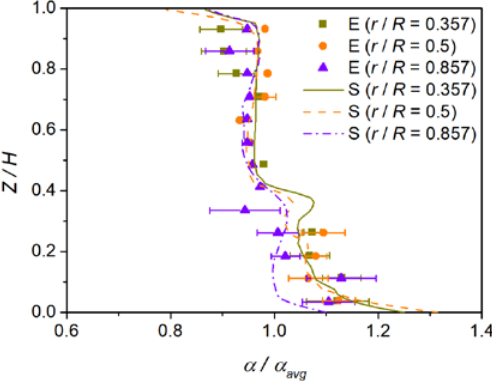
Figure 4. Comparison of numerical and experimental [30] results for axial profiles of the normalized solid volume fraction.